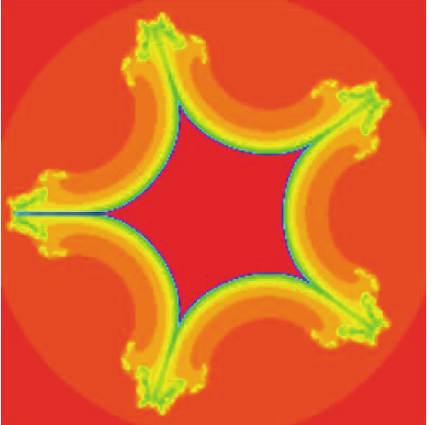
Figure 11: Relative superior multicorn for 𝑠 = 0.4 and 𝑠 󸀠 = 0.3 .